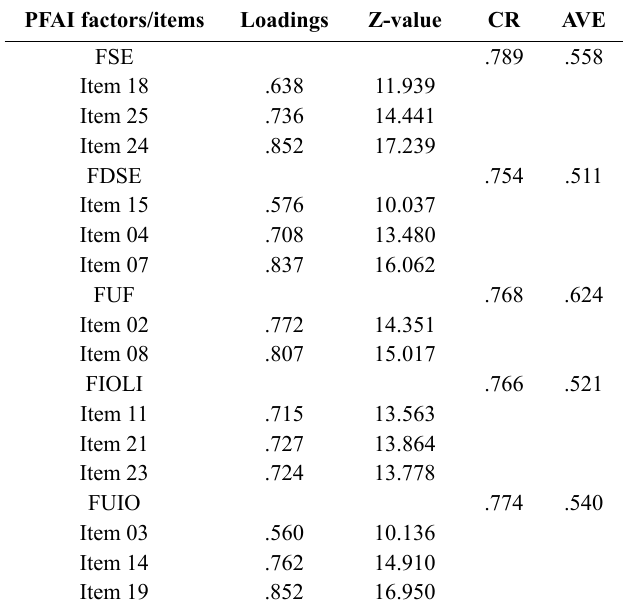
Table 1. PFAI’s Re-specified 1st Order Model – Factor Loadings, Z-val- ues, Composite Reliability (CR), and Average Variance Extracted (AVE) PFAI